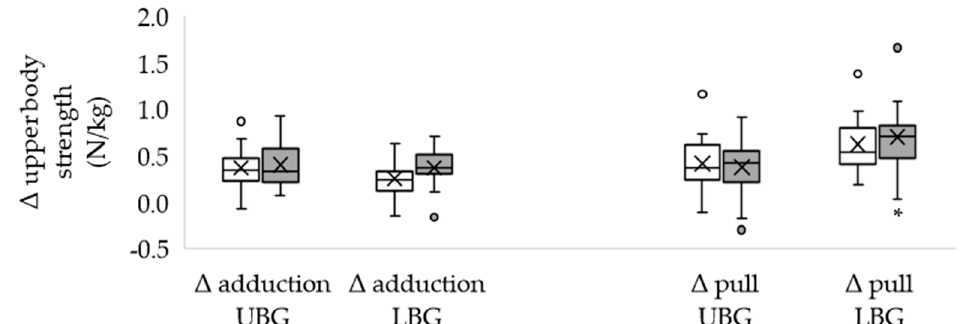
Figure 2. Differences between the final and the initial body weight adjusted maximum upper body strength (arm adduction and arm pull) in the upper body group and in the lower body group. Δ : differences; UBG ( n = 15): upper body group; LBG ( n = 13): lower body group; white box: right arm; grey box: left arm; circles represent discordant values; means are displayed by crosses and medians by crossbars; * significant difference between LBG and UBG, p < 0.040 (effect size r = 0.39).